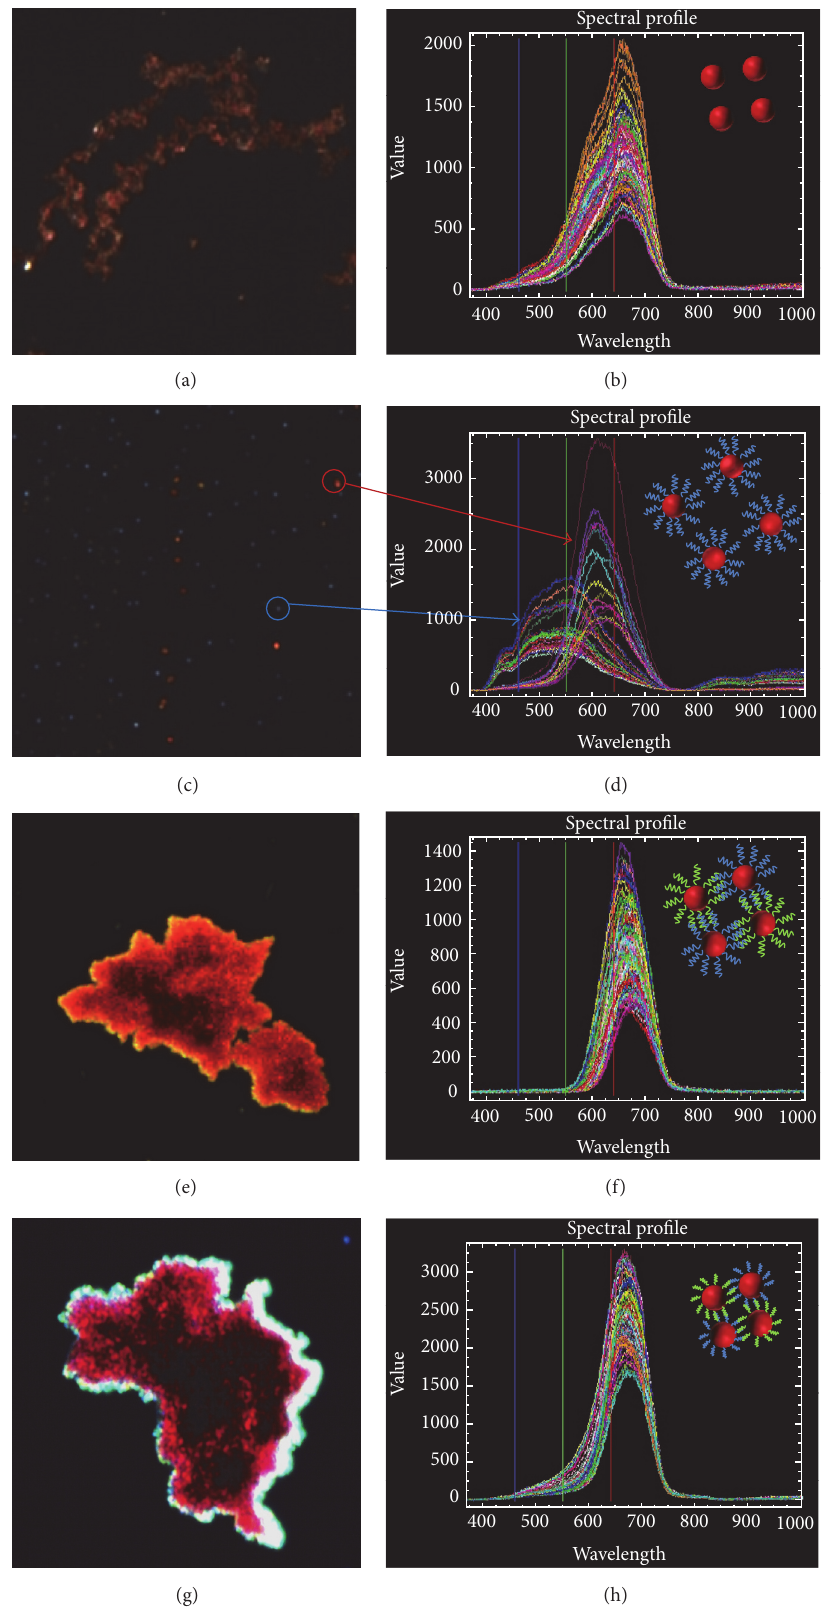
Figure 3: Hyperspectral imaging of unfunctionalized, functionalized, and hybridized 13 nm Au NPs. (a) Digital image and (b) spectra of unfunctionalized 13 nm Au NPs. (c) Digital image and (d) spectra of ssDNA functionalized 13 nm Au A1 NPs. (e) Digital image and (f) spectra of hybridized 13nm Au A1 + C1 NPs. (g) Digital image and (h) spectra of hybridized 13 nm Au A1-pA + C1-pA